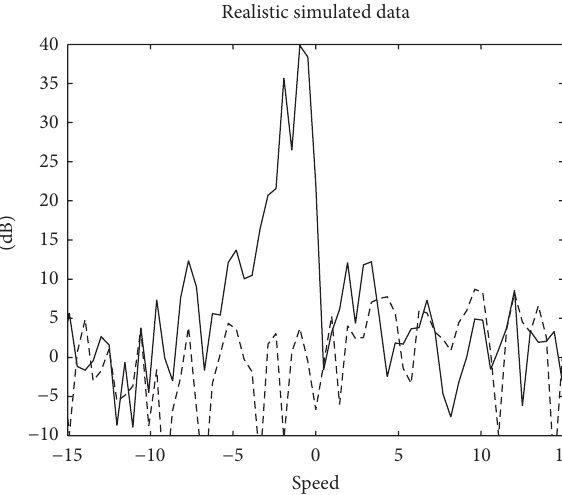
Figure 4: Range-Doppler map of the nonadaptive processing (pos- itive speeds) and the sum channel (negative speeds) on error-free data simulated data.